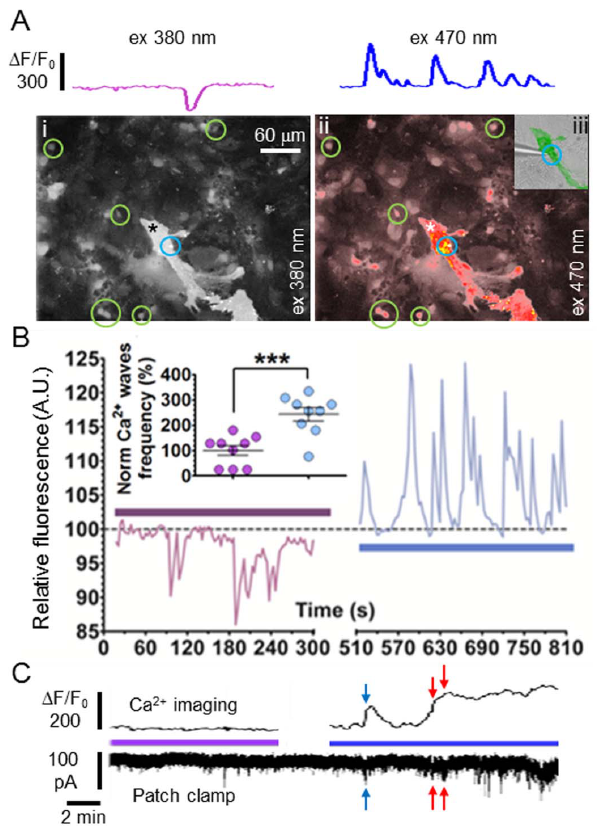
Figure 3. ChR2 + asctrocytic stimulation modulates neuronal calcium waves frequency. A , Bottom, snapshots from Ca 2 + experiments during stimulation with 380 nm ( i ) and 470 nm ( ii ) light. Green circles indicate neurons, one of which (blue circle) was co- localizated with the ChR-2 positive astrocyte (star). Top, time course of one of the not colocalized neurons (circled in green). B ,Time course of all circled neurons mean relative fluorescence and (inset)single cell measurement of calcium wave frequency (paired t test p , 0.0001). C , Concurrent patch clamp and Ca 2 + imaging time course of the neuron circled in blue in A ( iii ). The red arrow shows the first wave (top) syncronised with the first sEPSCs burst and the red arrows show following sEPSCs bursts concomitant to internal calcium concentration increase.